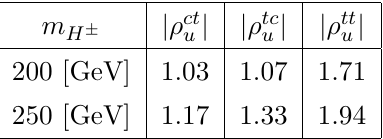
Table 2 . The upper bounds from the global (cid:12)tting: (cid:0) 0 : 055 (cid:20) (cid:1) C 7 ( m b ) (cid:20) 0 : 02. m m = 200 GeV and 250 GeV, H (cid:6)